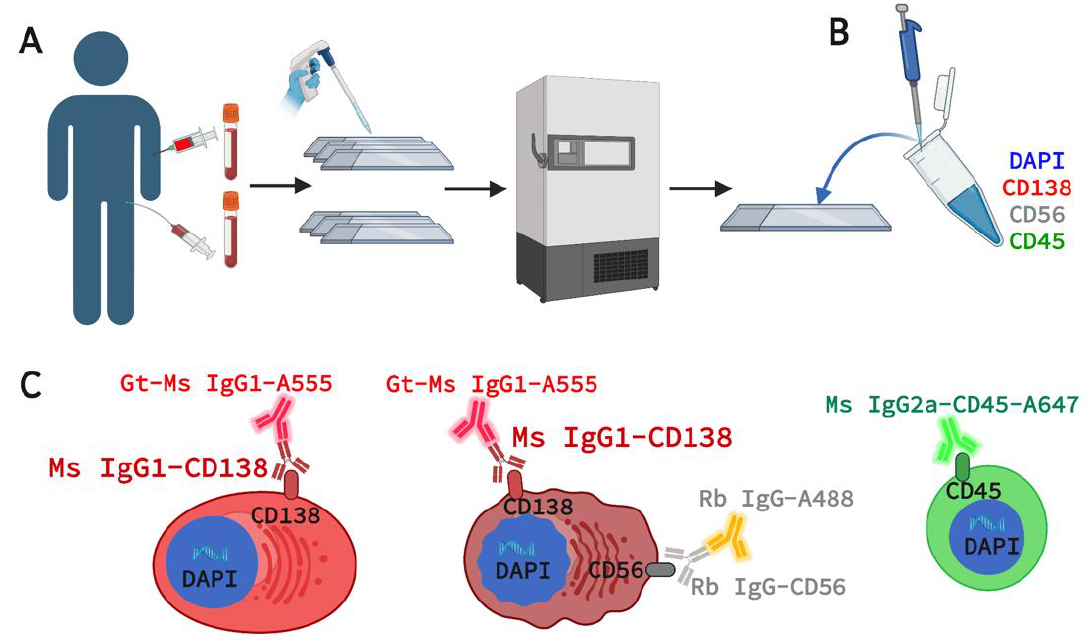
Figure 1. HDSCA-based 4-plex Immunofluorescence for Rare Single Cell Detection in Plasma Cells. ( A ) Paired sample acquisition, processing, and cryo-banking. ( B ) Slides are stained with a cocktail of antibody markers targeting cells of interest. ( C ) Immuno-targeting for normal PC (CD138+ only), candidate malignant PCs (CD138+CD56+), and common WBCs (CD45+ only). Gt = Goat, Ms = Mouse, Rb = Rabbit, Ig = immunoglobulin, DAPI = 4′,6-diamidino-2-phenylindole, A555 = Alexa Fluor ® 555, A488 = Alexa FluorPLUS ® 488, A647 = Alexa647.